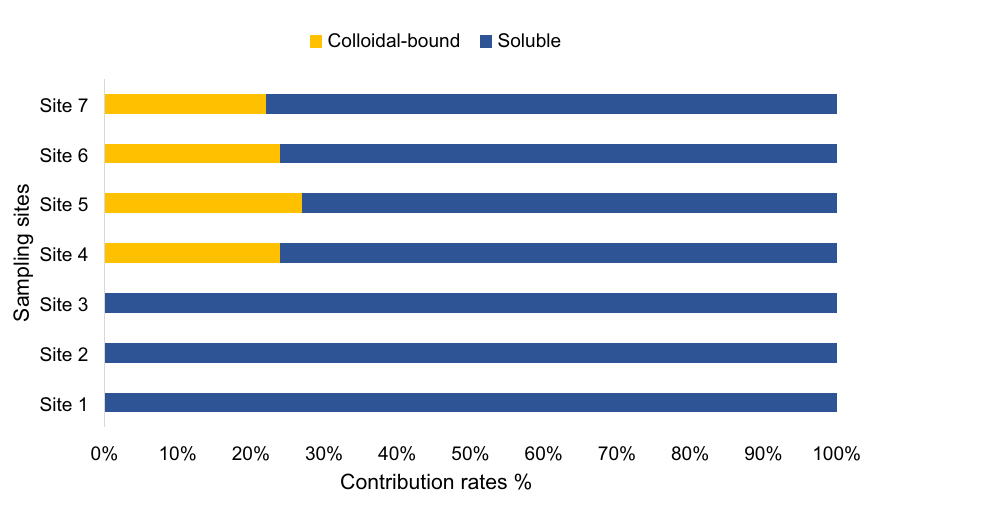
Figure 6. Proportion of BPA in soluble and colloidal phases in Bentong